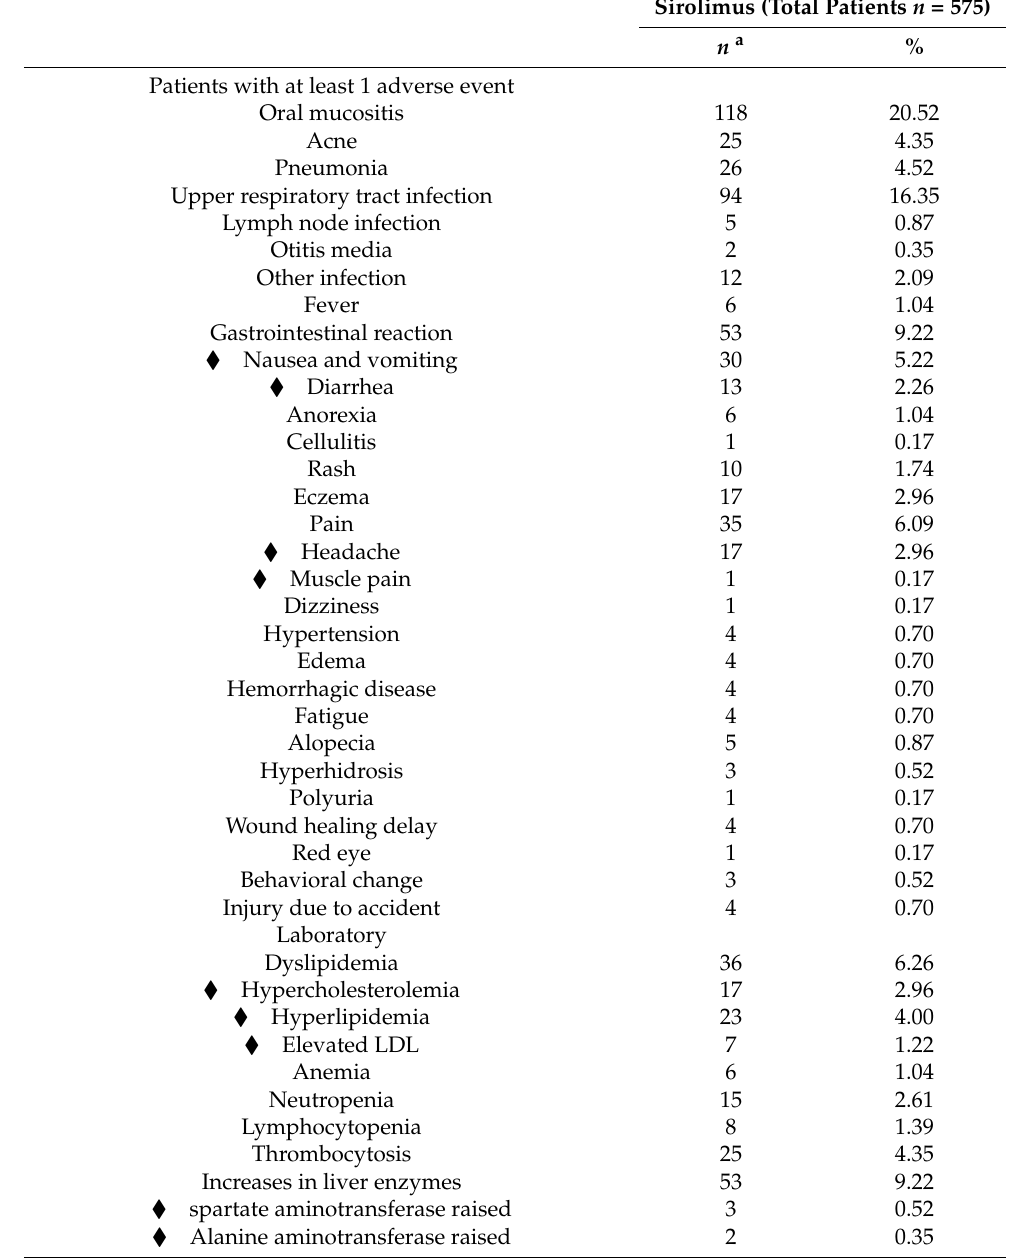
Table 4. Summary of adverse